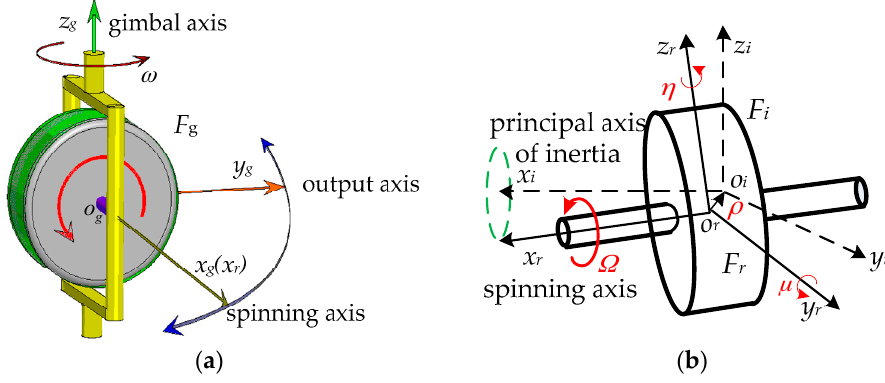
Figure 1. Schematics of SGCMG and rotor imbalance. ( a ) SGCMG; ( b ) Rotor imbalance.